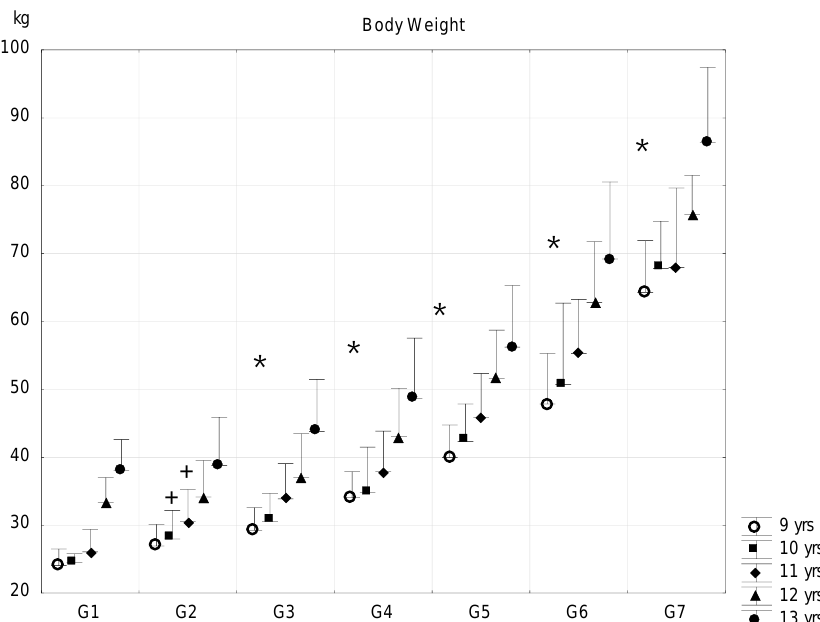
Figure 2. Relationship between body fat percentage and body weight (mean + SD). 1—F% < 8.00; 2— F% = 8–11.99; 3—F% = 12.00–15.99; 4—F% = 16.00–19.99; 5—F% = 20.00–23.99; 6—F% = 24.00–27.99; 7—F% > 28; F% body fat percentage; * significant difference among subsequent groups; + significant difference in certain consecutive groups, p < 0.05.